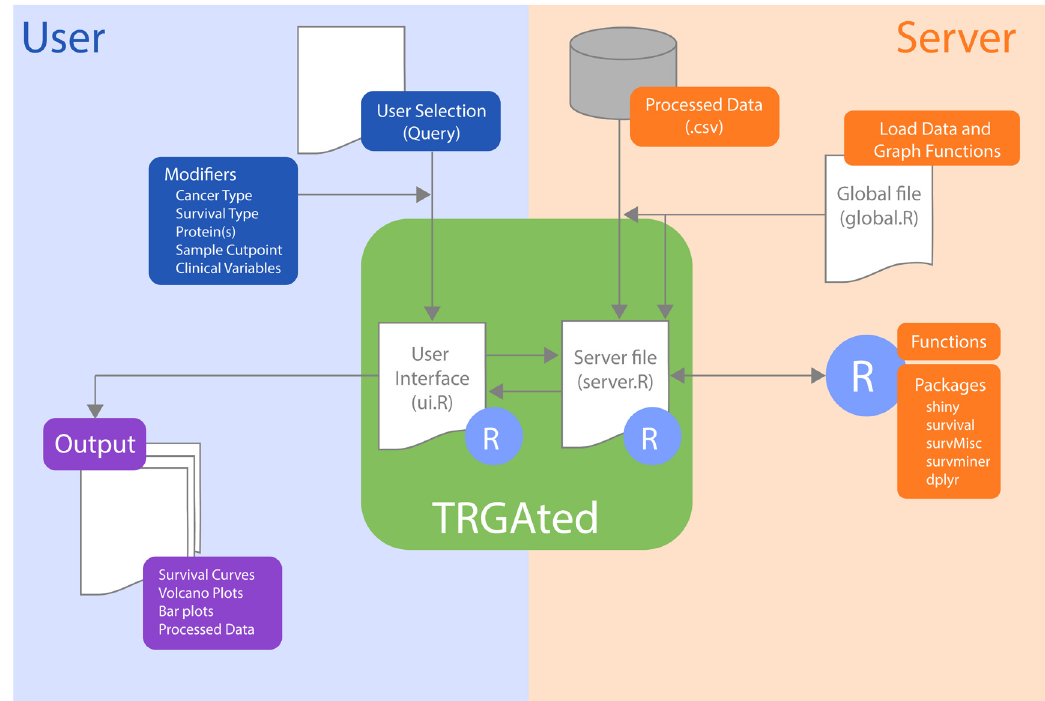
Figure 1. Diagram of the implementation of TRGAted. Each file communicates within the R Shiny framework. On the user side (left, blue), users select pertinent cancer type, protein of interest, and clinical variables into the CSS-enabled user interface. This information is received by the server file enabling the subsequent run in R. On the server side (right, orange), the specific cancer type from the database, R packages, and functions are retrieved and executed. After execution, the server file provides both tabular and graphical output (purple) to the user